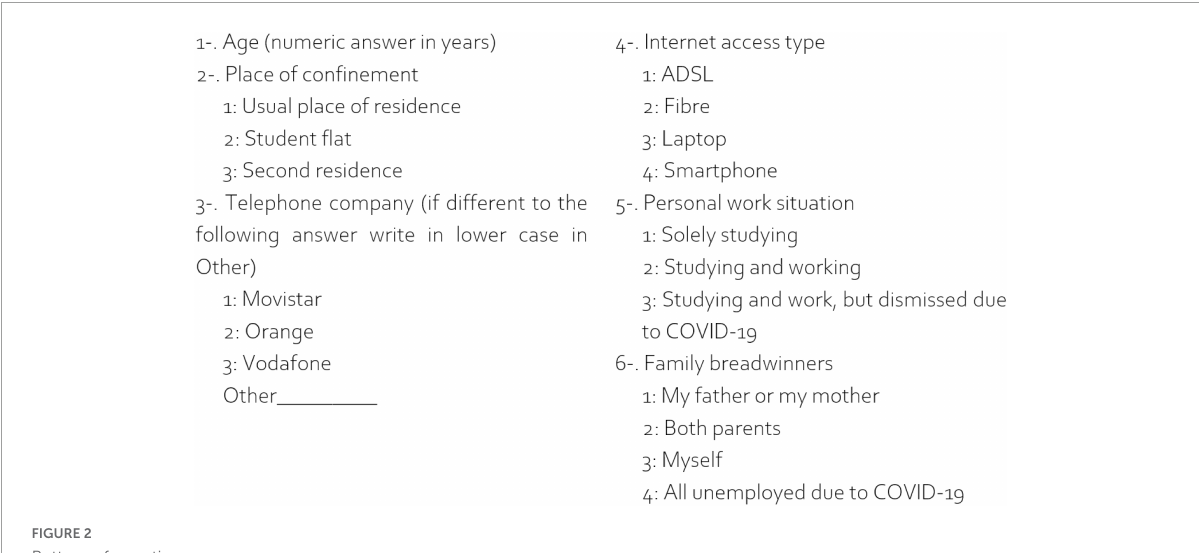
FIGURE2 Battery of